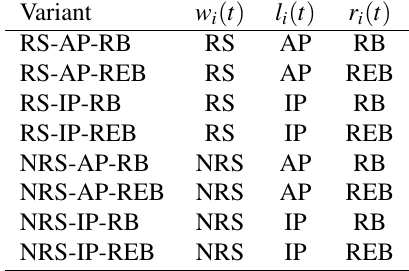
Table 2. Learning scheme